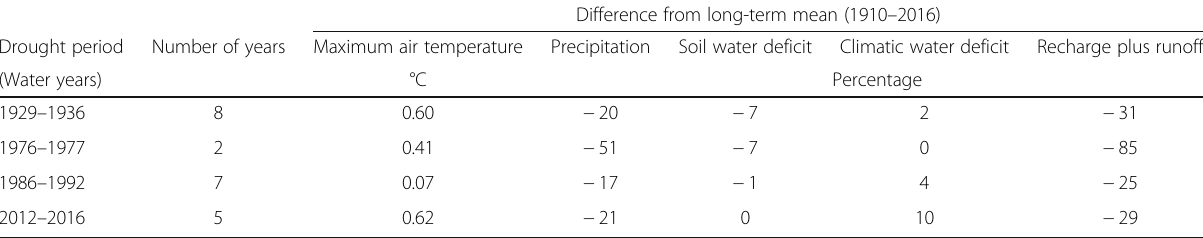
Table 1 Drought periods used for extreme drought scenarios and associated anomalies from the long-term mean (1910 – 2016) for climate and hydrologic